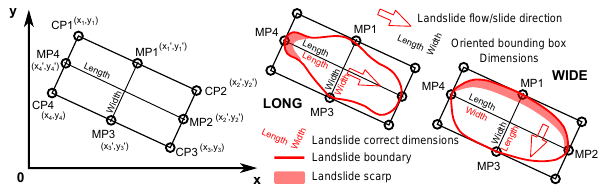
Figure 5. Geometry of the minimum oriented bounding box. The left panel shows the geometry of the oriented bounding box; the center panel shows the geometry of a long landslide bounding box; the right panel shows the geometry of a wide landslide